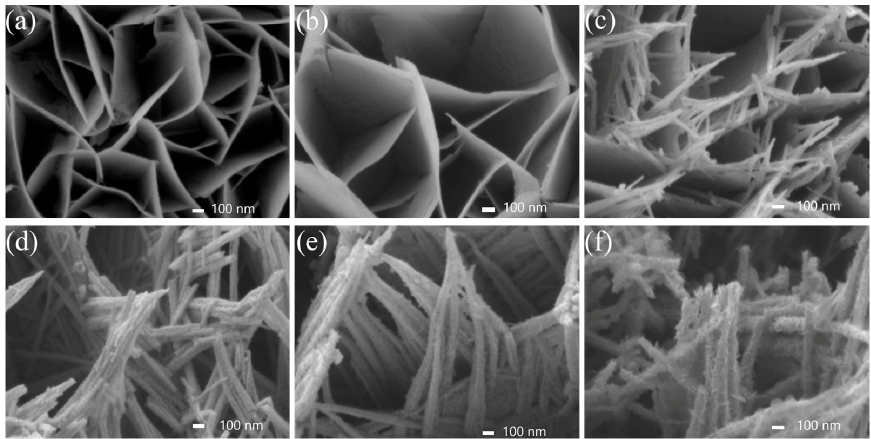
Figure 2. SEM images of ( a ) NiO; ( b ) Ni 0.9 Co 0.1 O; ( c ) Ni 0.5 Co 0.5 O; ( d ) Ni 0.3 Co 0.7 O; ( e ) Ni 0.1 Co 0.9 O; ( f ) Co 3 O 4 .